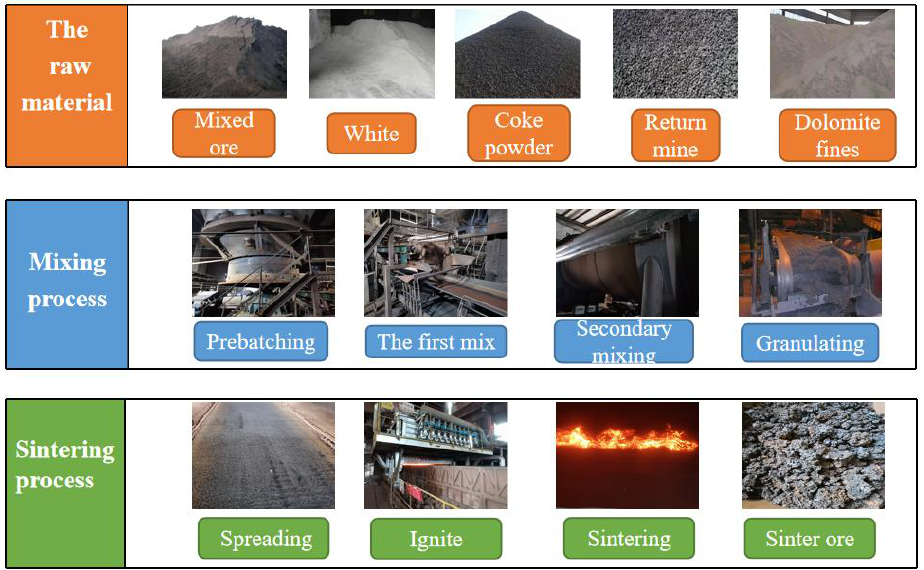
Figure 2. Sintering Metallogenesis process of iron ore powder.